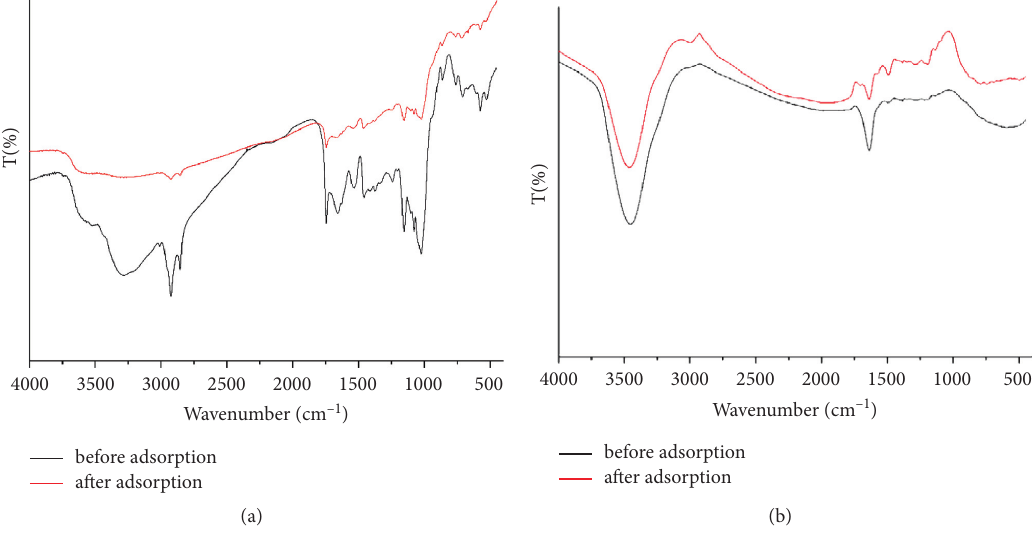
Figure 2: FTIR analysis of adsorbent surfaces (a) TR and (b) PSS before and after adsorption.